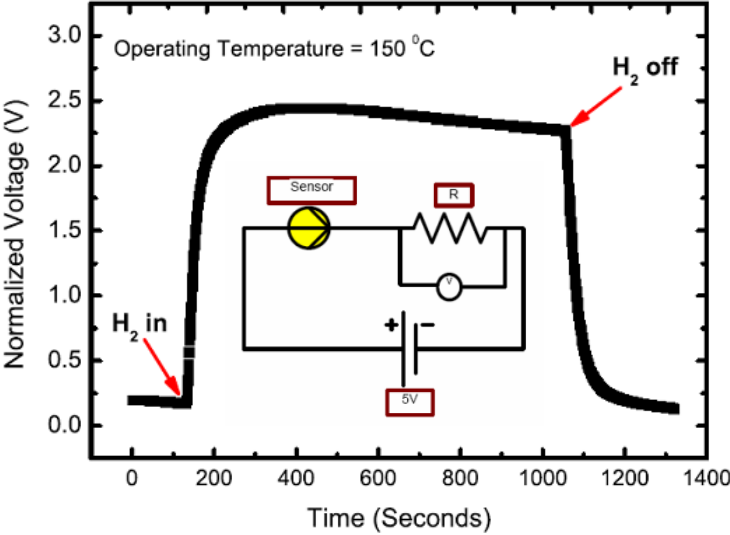
nanofiber towards 500 ppm hydrogen as 3